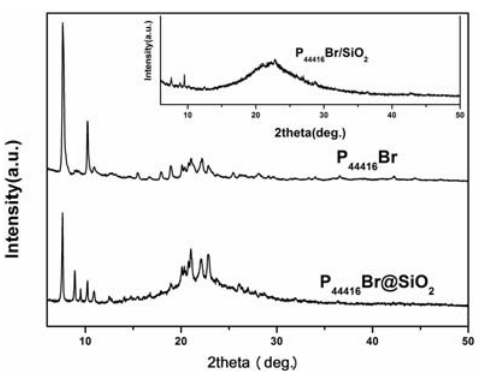
Br and the sample P 44416 Br/SiO 44416 2